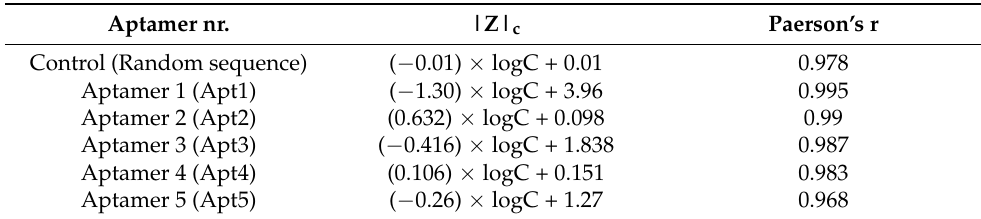
Table 2. Linear equations of the aptasensors. Aptamer nr. |Z|